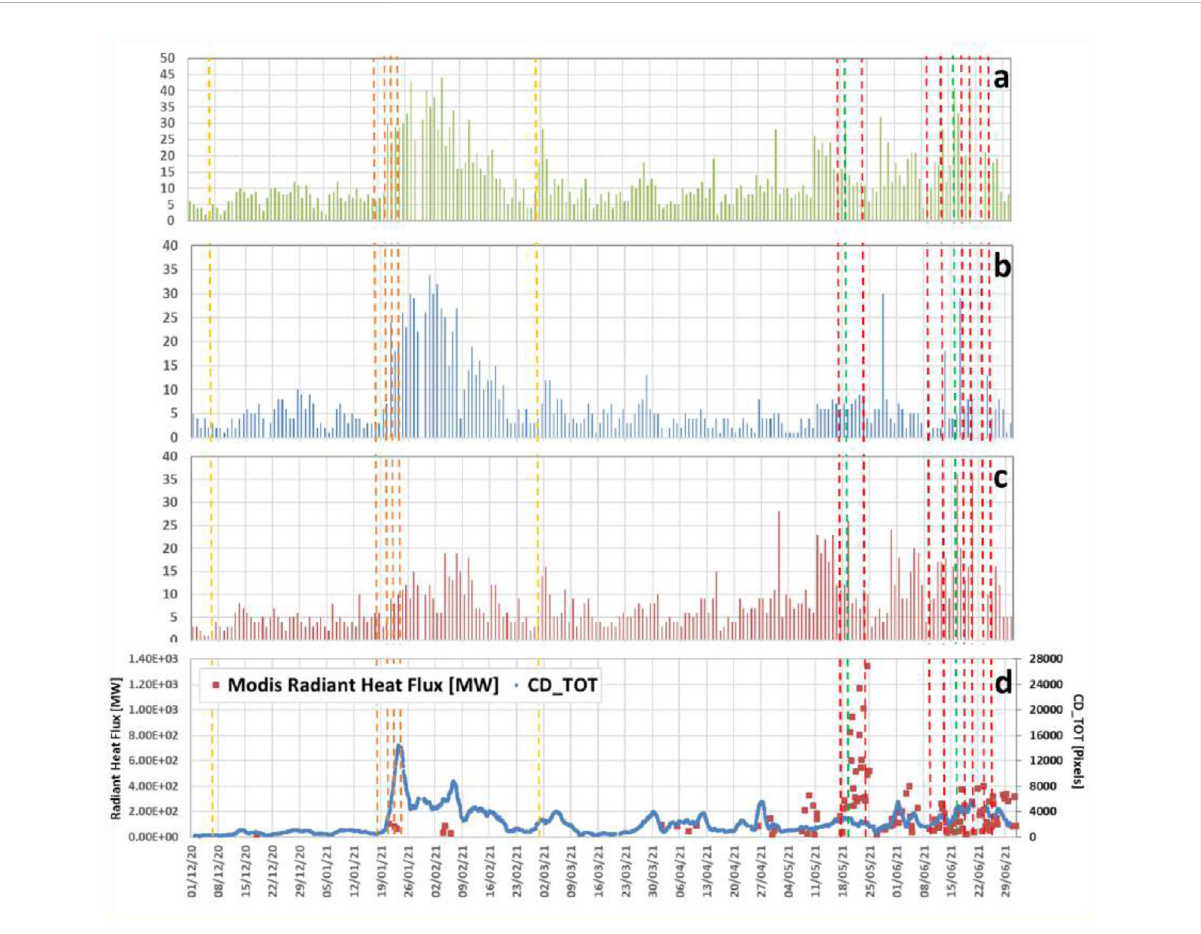
2020 and 30 June 2021. (A) Green histogram: total number of explosions per hour detected from all the summit vents vs. time. (B) Blue histogram: number of explosions detected from theNE crater zonevs. time. (C) Red histogram:number of explosions detected for the SWand CC crater